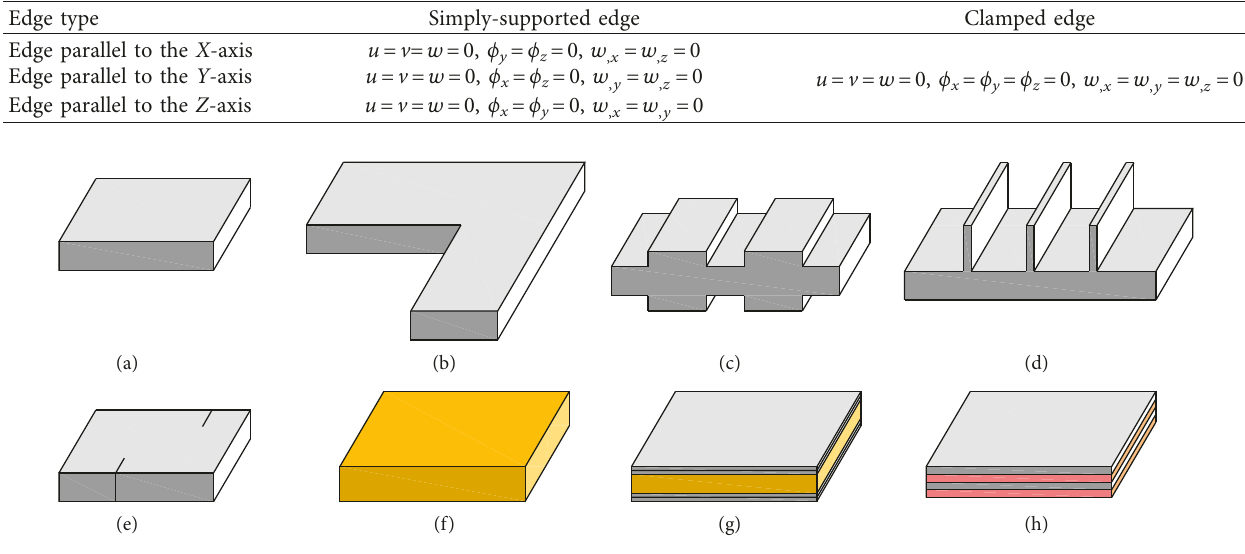
Table 1: Assignment of boundary conditions.